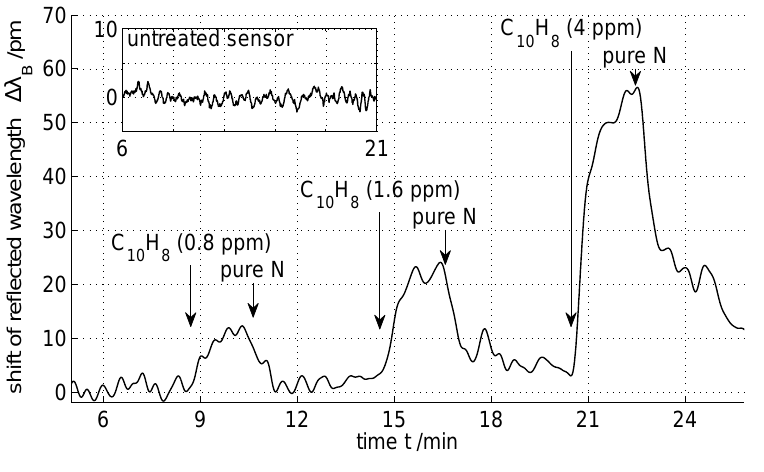
Figure 3. Shift of the reflected wavelength of the sensor coated with allylated (cid:13) -cyclodextrin to naphthalene in various concentrations (response of the untreated sensor is shown in the inset). Smoothed by Savitzky–Golay